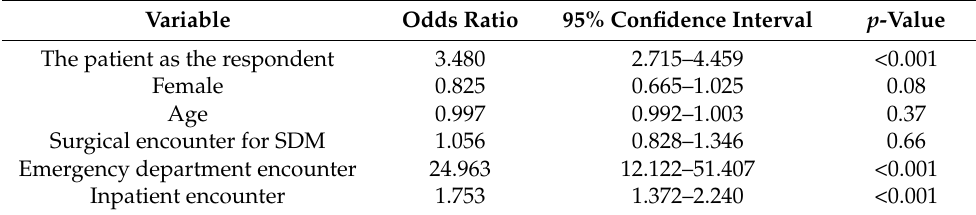
Table 5. Multivariate logistic regression analysis for the factors associated with preparedness for final decision-making ( n =